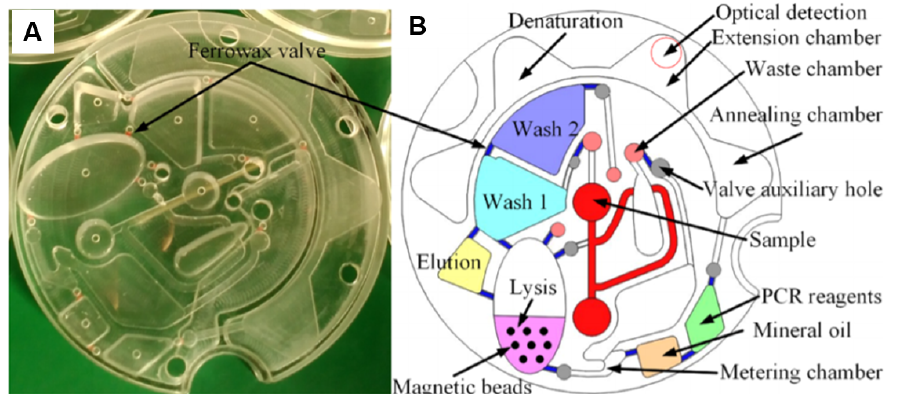
Figure 10. ( A ) The optically transparent disc and ( B ) the schematic of the LoaD architecture for HBV DNA detection in whole blood. Sample is inserted into the centre reservoir of device where pre-stored DNA extraction reagents in wash 1, 2, elution ad lysis buffers and magnetic beads. Ferrowax valves control the release and flow of each reagent to initiate the DNA extraction which then mixes with pre-stored primer and PCR reagents for amplification purposes. Reprinted with permission from [90]. Copyright 2019 American Chemical Society.